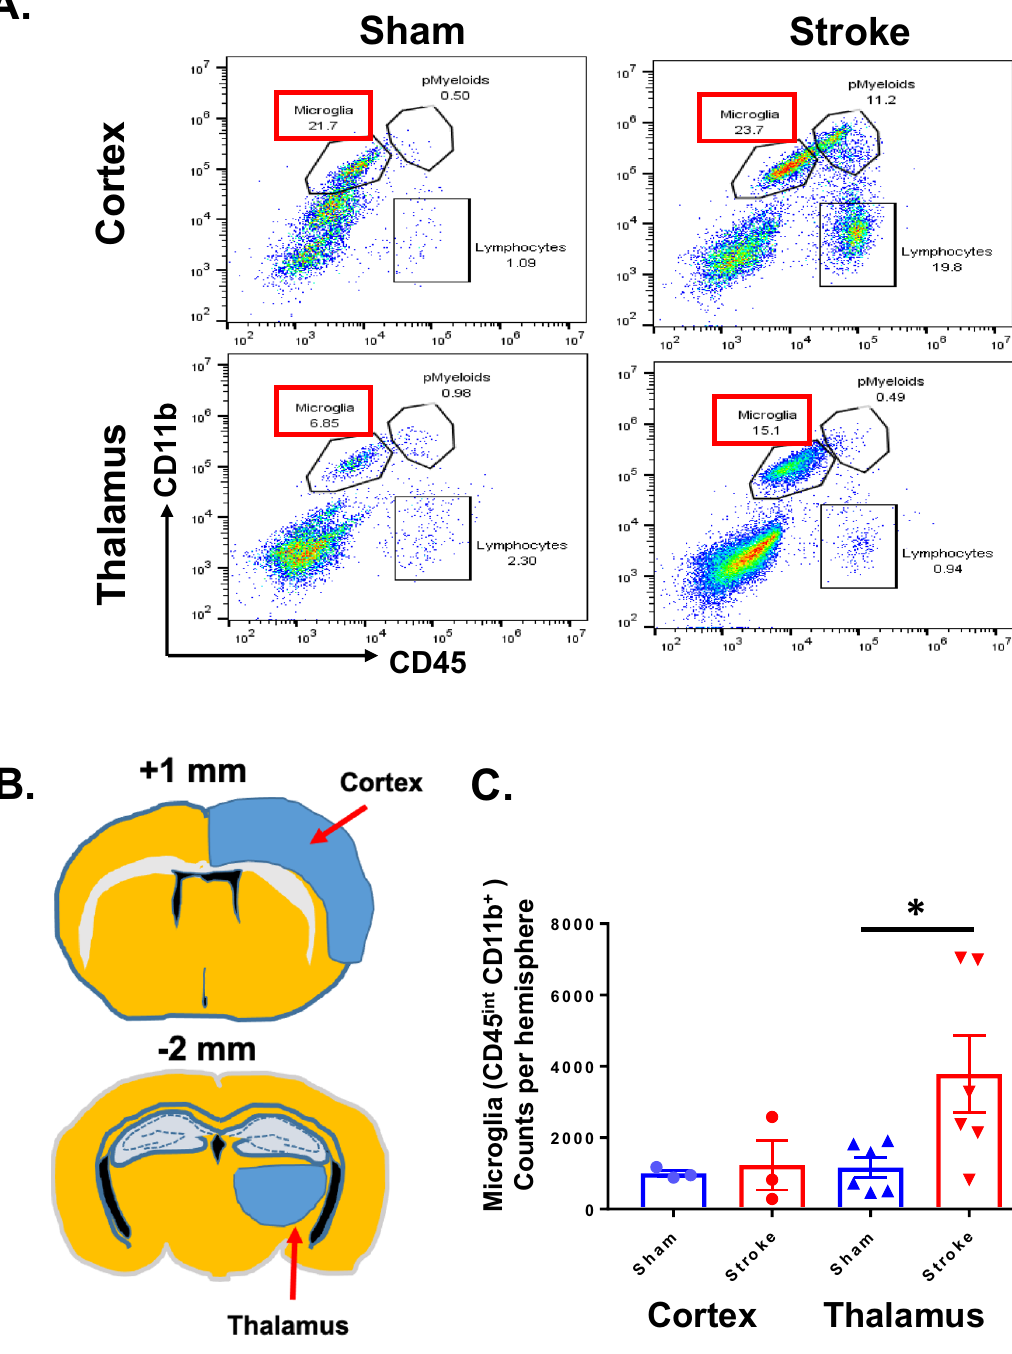
Figure 2. The resident microglial population increases in proportion and total number in the ipsilateral thalamus at PSD 14. At PSD 14, brains were harvested for cell cytometry. Single cell suspensions were obtained from cortex and thalamus. Cells were stained with CD45 antibody and CD11b antibody to measure the number and percentage of microglia in thalamus . ( A ) Representative cell cytometry plots generated from ipsilateral cortex and thalamus from sham and PSD 14 brains. The percentage of microglia, peripheral myeloid cells (pMyeloids), and lymphocytes is indicated numerically on the plots. ( B ) Illustration showing location of cortex and thalamus harvest sites from brain sections corresponding to + 1 or − 2 mm from bregma. ( C ) Number of CD45 Int /CD11b + cells in cortex and thalamus for sham and PSD 14 brains. * P < 0.05, unpaired t